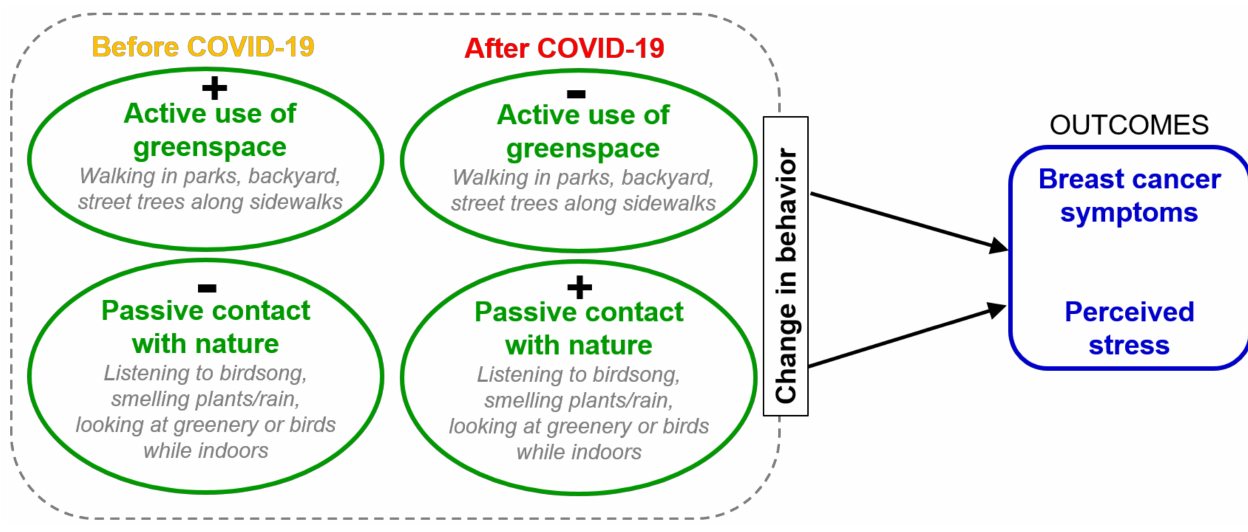
Figure 1. Conceptual